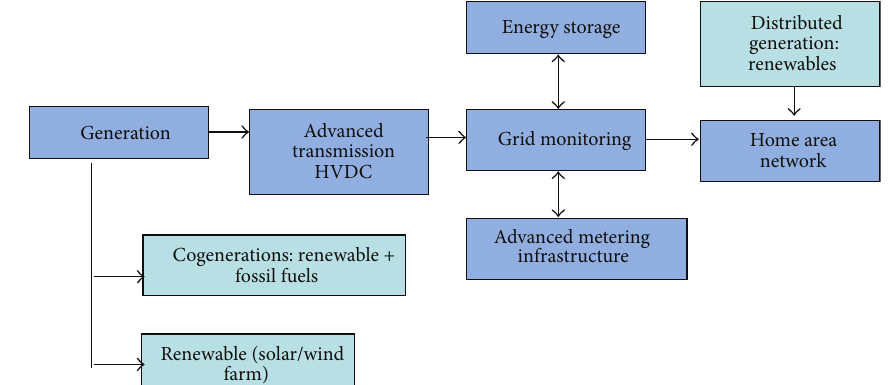
Figure 5: Block diagram of the smart grid concept [86].